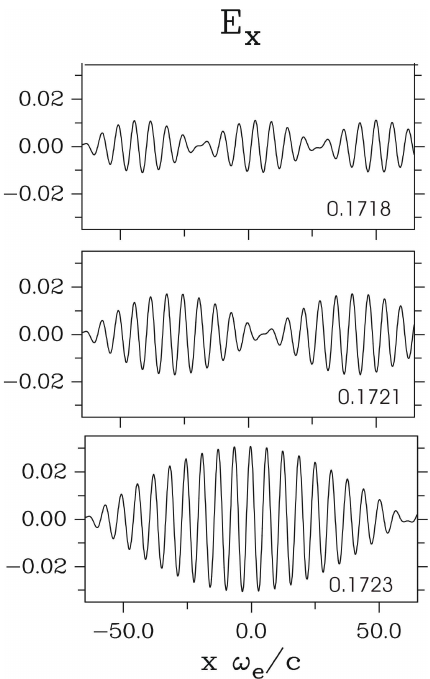
Fig. 9. Spatial profiles of the longitudinal electric field component (in units of E o = V Ae B o ) for three values of the oscilliton speed M e = U/V Ae . Obviously the waveform is very sensitive to values of M e . For M e ≥ 0 . 1725 whistler oscillitons no longer